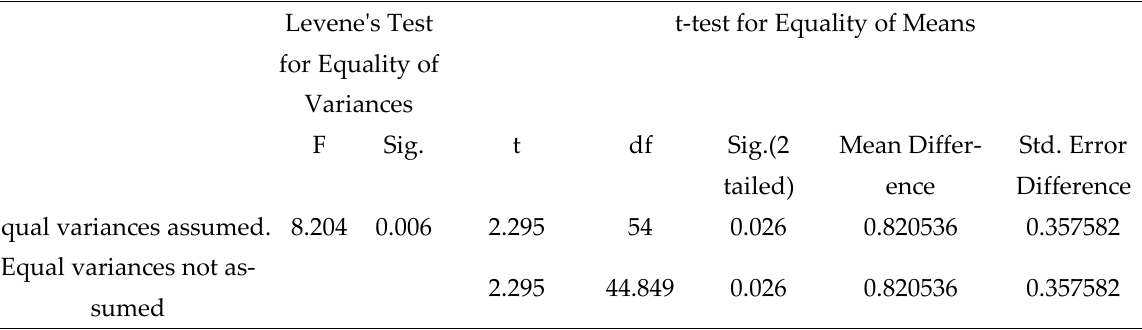
Table 5: Independed Student T-test for S. mutans and C. albicans